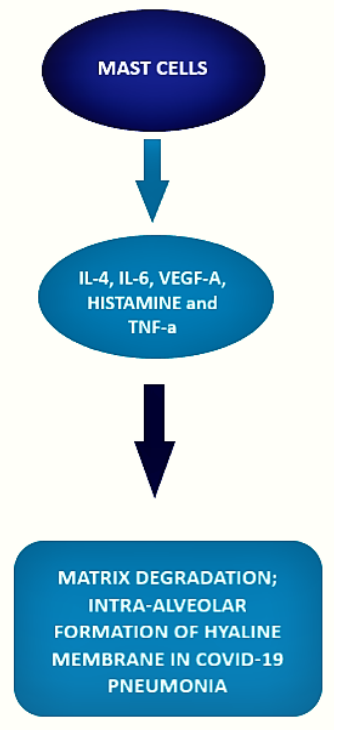
Figure 2. Role of mast cells in COVID-19 .